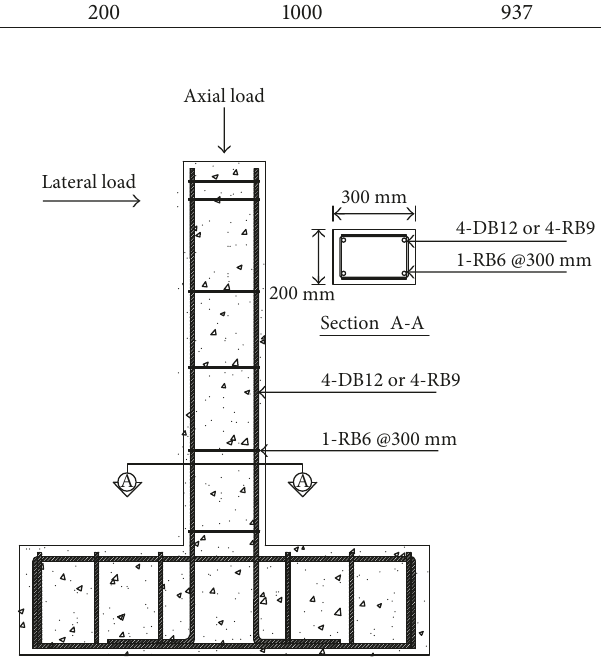
Figure 3: Reinforcement details of column